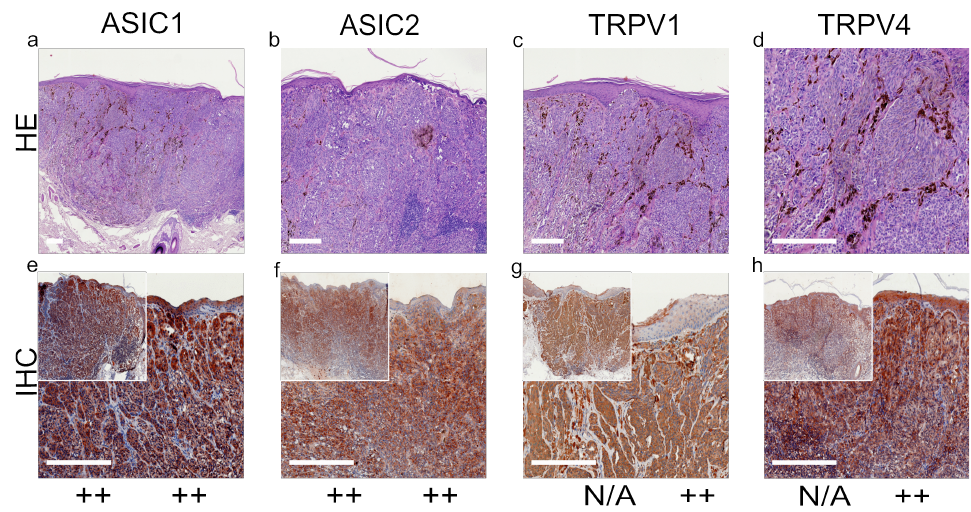
Figure 4. Immunohistochemistry of MM. Immunohistochemical staining for ASIC1, ASIC2, TRPV1 and TRPV4 in MM tissue. ( a – d ) Histochemical H&E staining, ( e – h ) immunohistochemical staining, inserted smaller pictures represent a two times larger perspective. Scale bars represent 200 µm. ( a – h ) Patient 30.